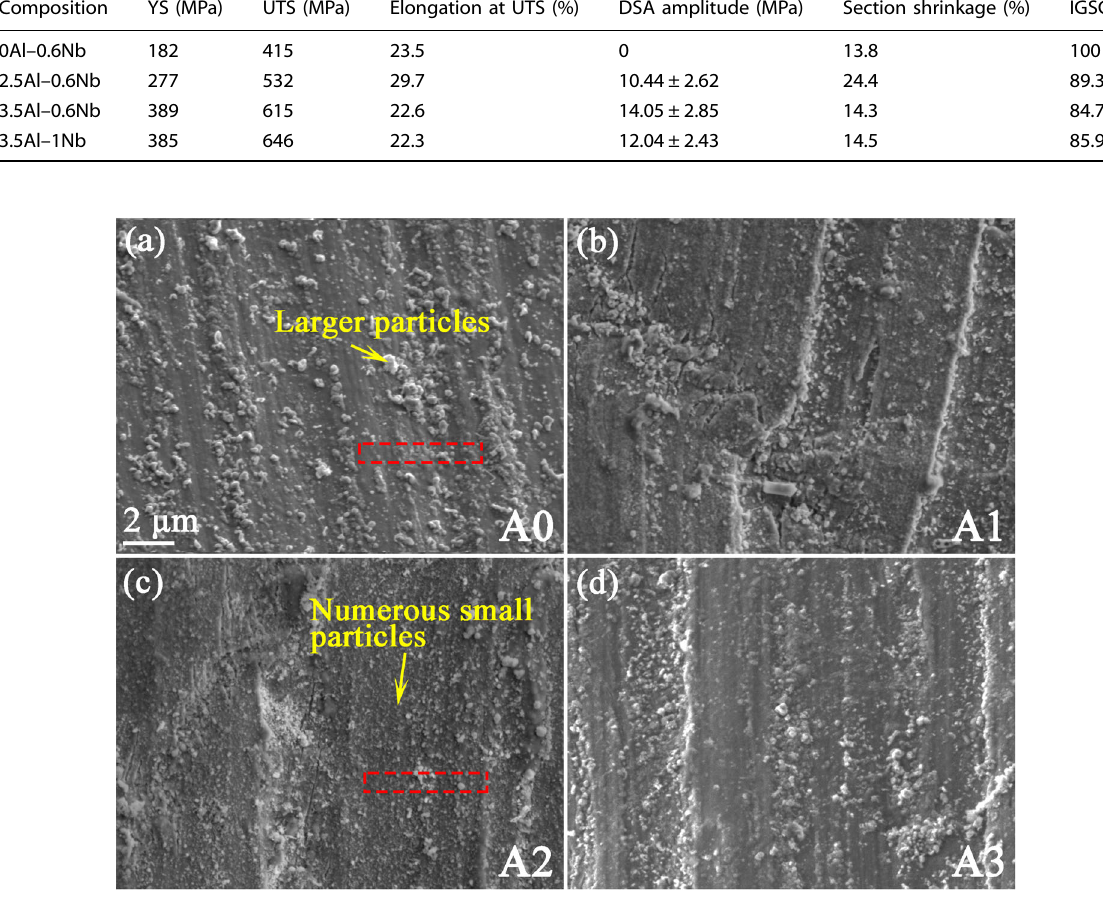
Table 2. Data obtained from SSRT tests at 600 °C/10 MPa sCO 2 . No.